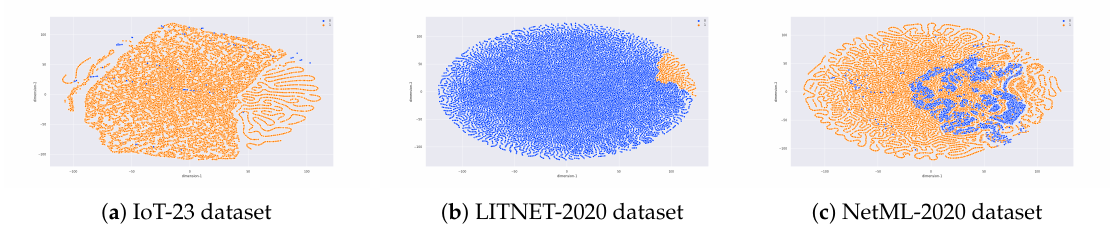
Figure 2. The figures depict the Deep Sparse AutoEncoder (DSAE) reconstruction procedure side-by-side with the bottleneck representation of the samples on three benchmark datasets. The x -axis and y -axis represent 1 dimension vs. 2 and the colors stand for attack classes (blue—benign, orange—malicious).